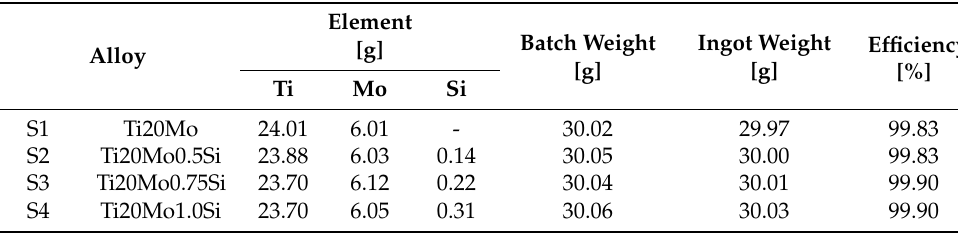
Table 1. Calculation of the metallic load for the experimental